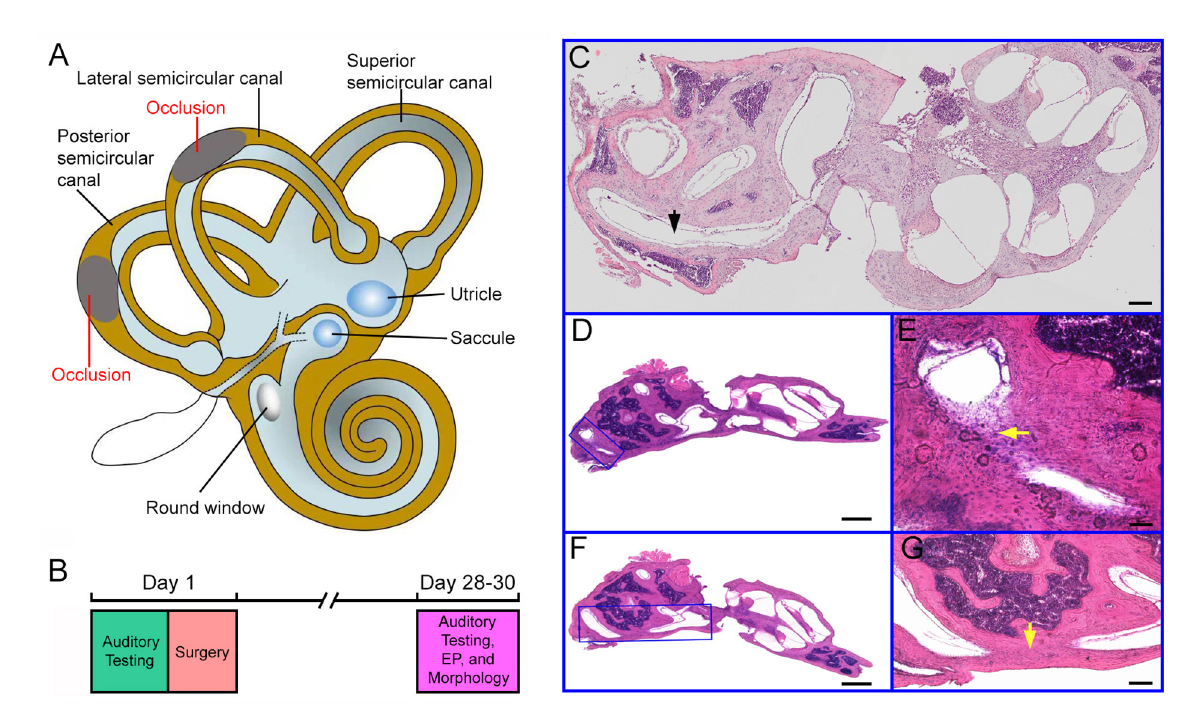
FIGURE1 Experimental design and histology of the cochlea and semicircular canals. (A) Schematic drawing of the inner ear with the cochlea, the vestibule and the semicircular canals. Occlusions of the lateral and posterior semicircular canals are indicated in the drawing. (B) Experimental design and timeline for the surgery and assessment of auditory function and hair cell morphology. (C) Cross section (H and E staining) of the inner ear from a control ear. The lateral semicircular canal is marked in the picture. Bar: 50 µ m. (D) Cross section of the inner ear from a surgical ear with posterior semicircular canal blocked. The area with occlusion is marked with a blue frame. (E) High magnification view of the area shown in (D) . The area with occlusion is marked by a yellow arrow. (F) Image of cross section of the inner ear from a surgical ear with lateral semicircular canal blocked. The area with occlusion is marked with a blue frame. (G) High magnification view of the area shown in (F) . The area with occlusion is marked by a yellow arrow. Bar for (D,F) : 200 µ m. Bar for (E,G) : 50 µ